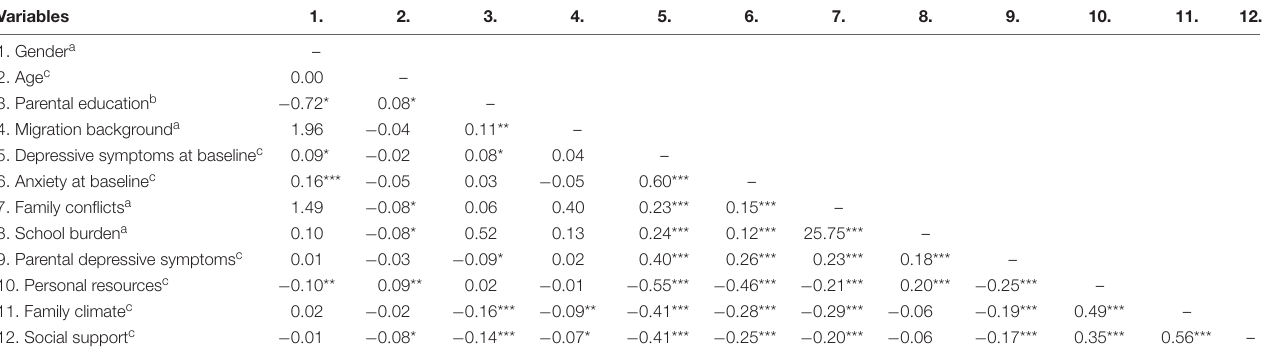
TABLE 2 | Zero-order correlations among predictor variables.